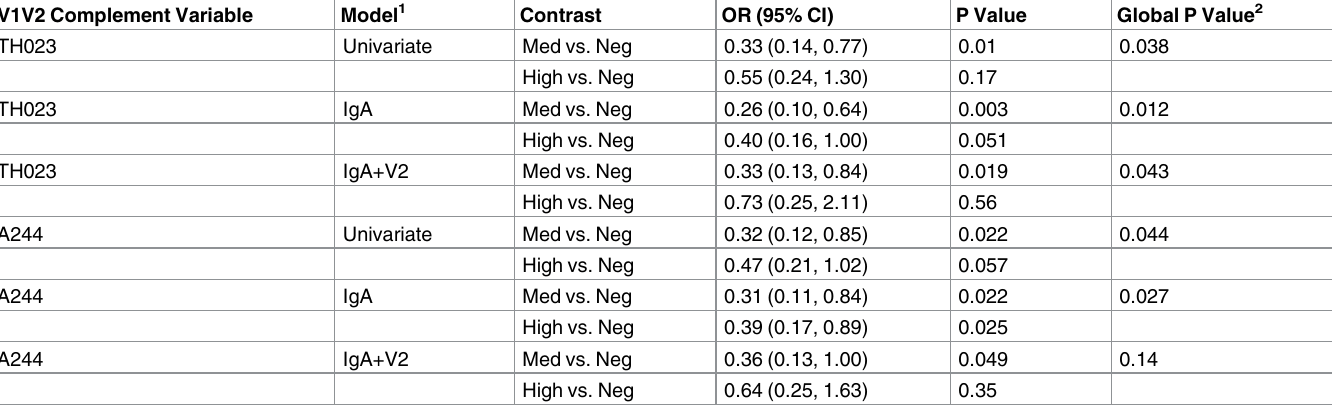
Table 4. Results testing the correlation of categorical complement readouts with HIV-1 infection for all models and all variables analyzed. V1V2 Complement Variable